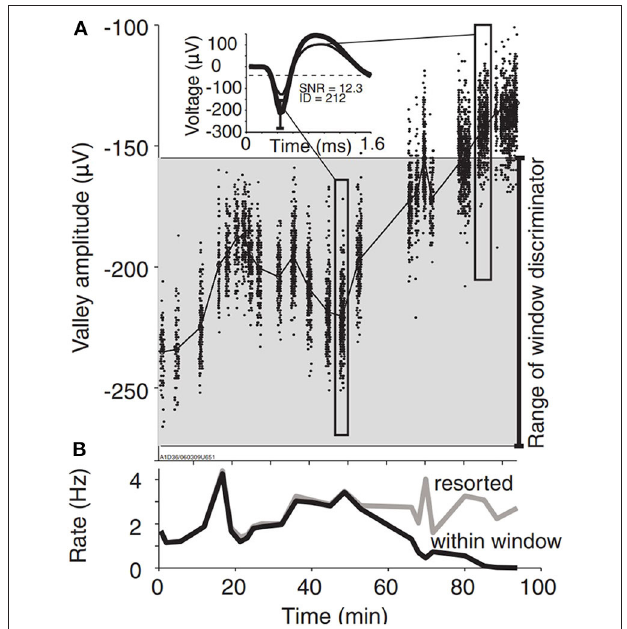
FIGURE 7 | Spike amplitude instability causes spike detection error. (A) A representative unit demonstrates large spike amplitude instability. The gray shaded area covers the amplitude range between the upper and lower boundaries of the window discriminator as determined manually by the experimenter. Spikes falling outside of these boundaries remained undetected during the online experiment. Inset: average spike waveforms during selected time periods indicated by elongated rectangles. (B) Spike rates as determined by online (within window, black) and retrospectively discriminated spikes (resorted, gray). Apparent decline in the online firing rate results from failure of the smaller waveforms to satisfy the discriminator parameters. Figure and caption reprinted with permission from Perge et al. (2013). © IOP Publishing. All rights reserved. Courtesy of